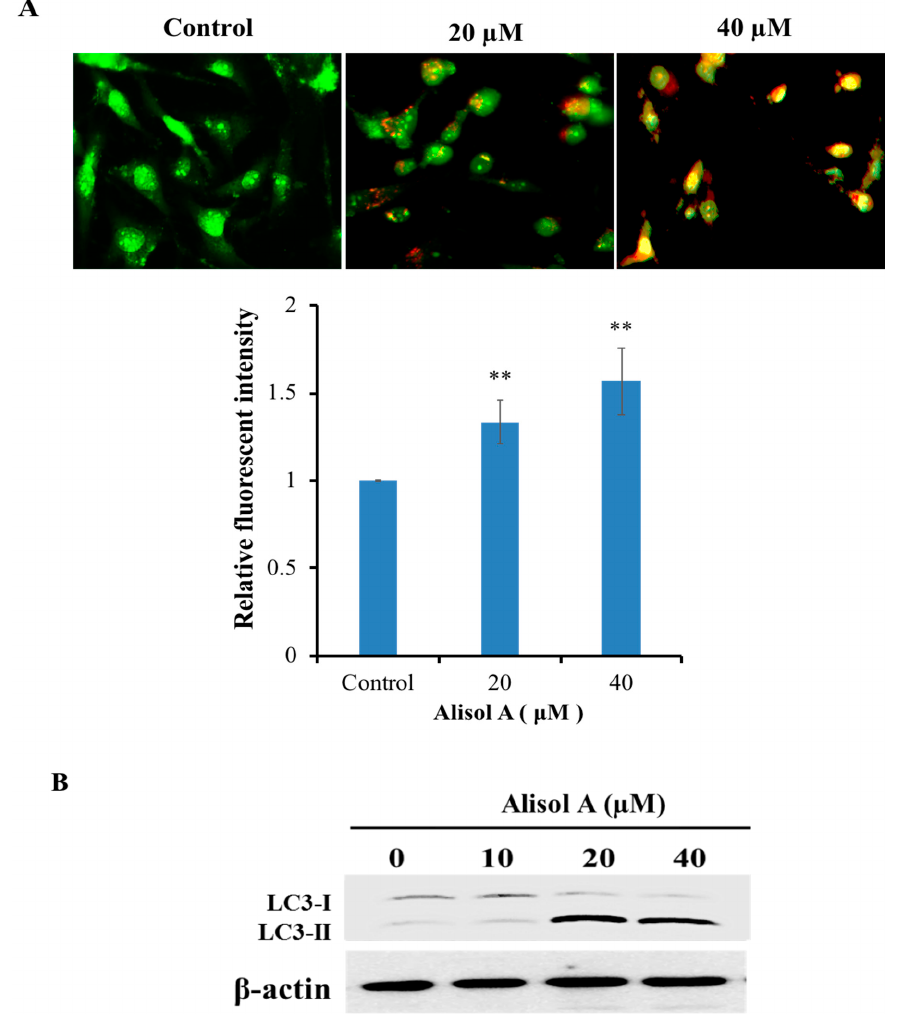
Figure 3. Effects of alisol A on induction of autophagy. ( A ) Autophagy in alisol A ‐ treated MDA ‐ MB ‐ 231 cells were stained with AO and examined under a fluorescence microscope. Quantitation of formation of autophagolysosomes in alisol A ‐ treated cancer cells was performed. ( B ) Western blotting analysis of the protein expression of LC3 in MDA ‐ MB ‐ 231 cells treated with alisol A for 12 h. Data are expressed as mean ± S.D of at least three independent experiments. ** p < 0.01.